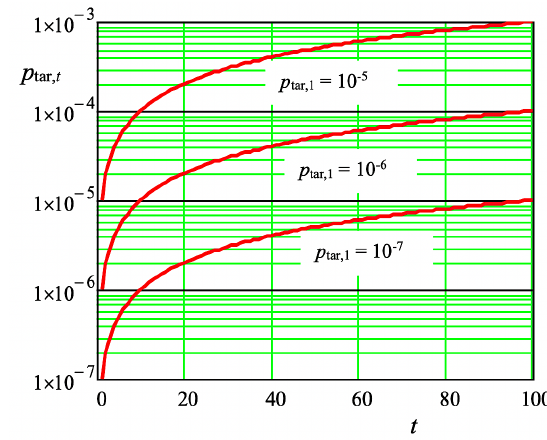
Figure 3. Variation of the target probabilities p with reference time t in years for basic probabilities for one year - p tar, 1 = 10 − 5 , 10 − 6 and 10 − 7